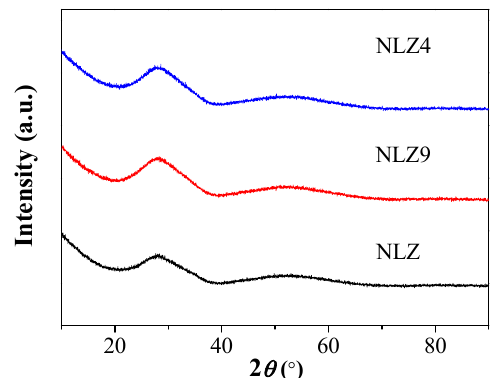
Fig. 1 Measured XRD patterns of powders NLZ, NLZ4, and